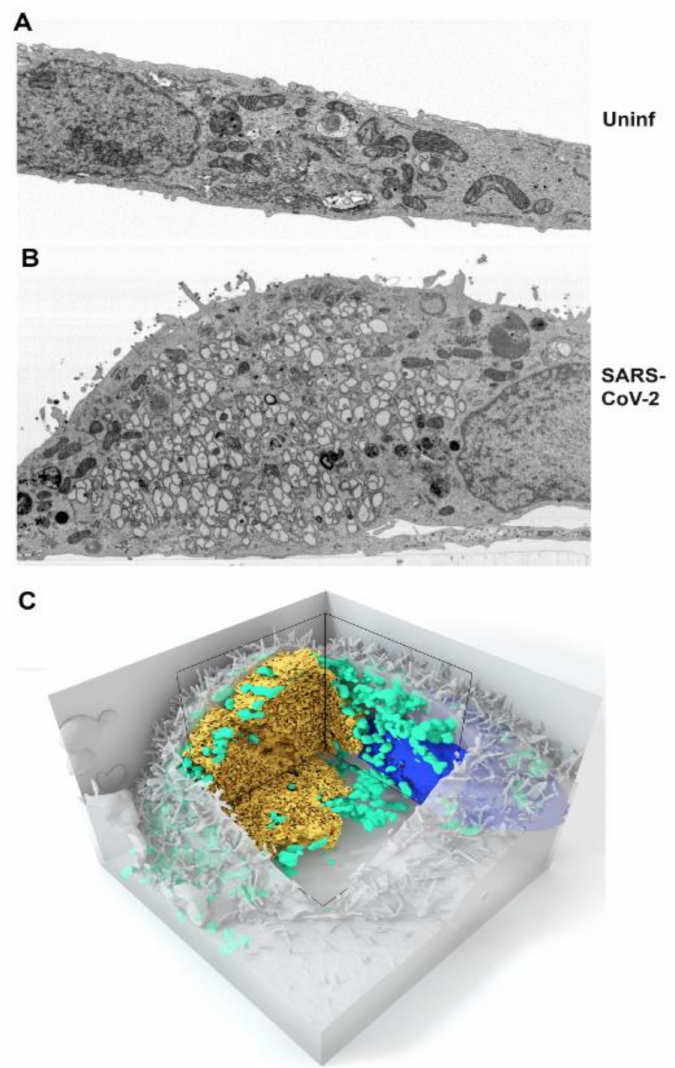
Figure 2. Vero E6 cells were mock-infected ( A ) or SARS-CoV-2 infected ( B ) and fixed at 24 h post- infection for Focused Ion Beam-Scanning Electron Microscopy (FIB-SEM). Single slices are shown in panels ( A , B ). The full image stacks are shown in Supplemental Video S1. ( C ) 3D volume rendering of the SARS-CoV-2 infected cell depicted in panel B and the Supplemental Movie Video S1. The replication complex is depicted in gold. Mitochondria are shown in green and the nucleus in